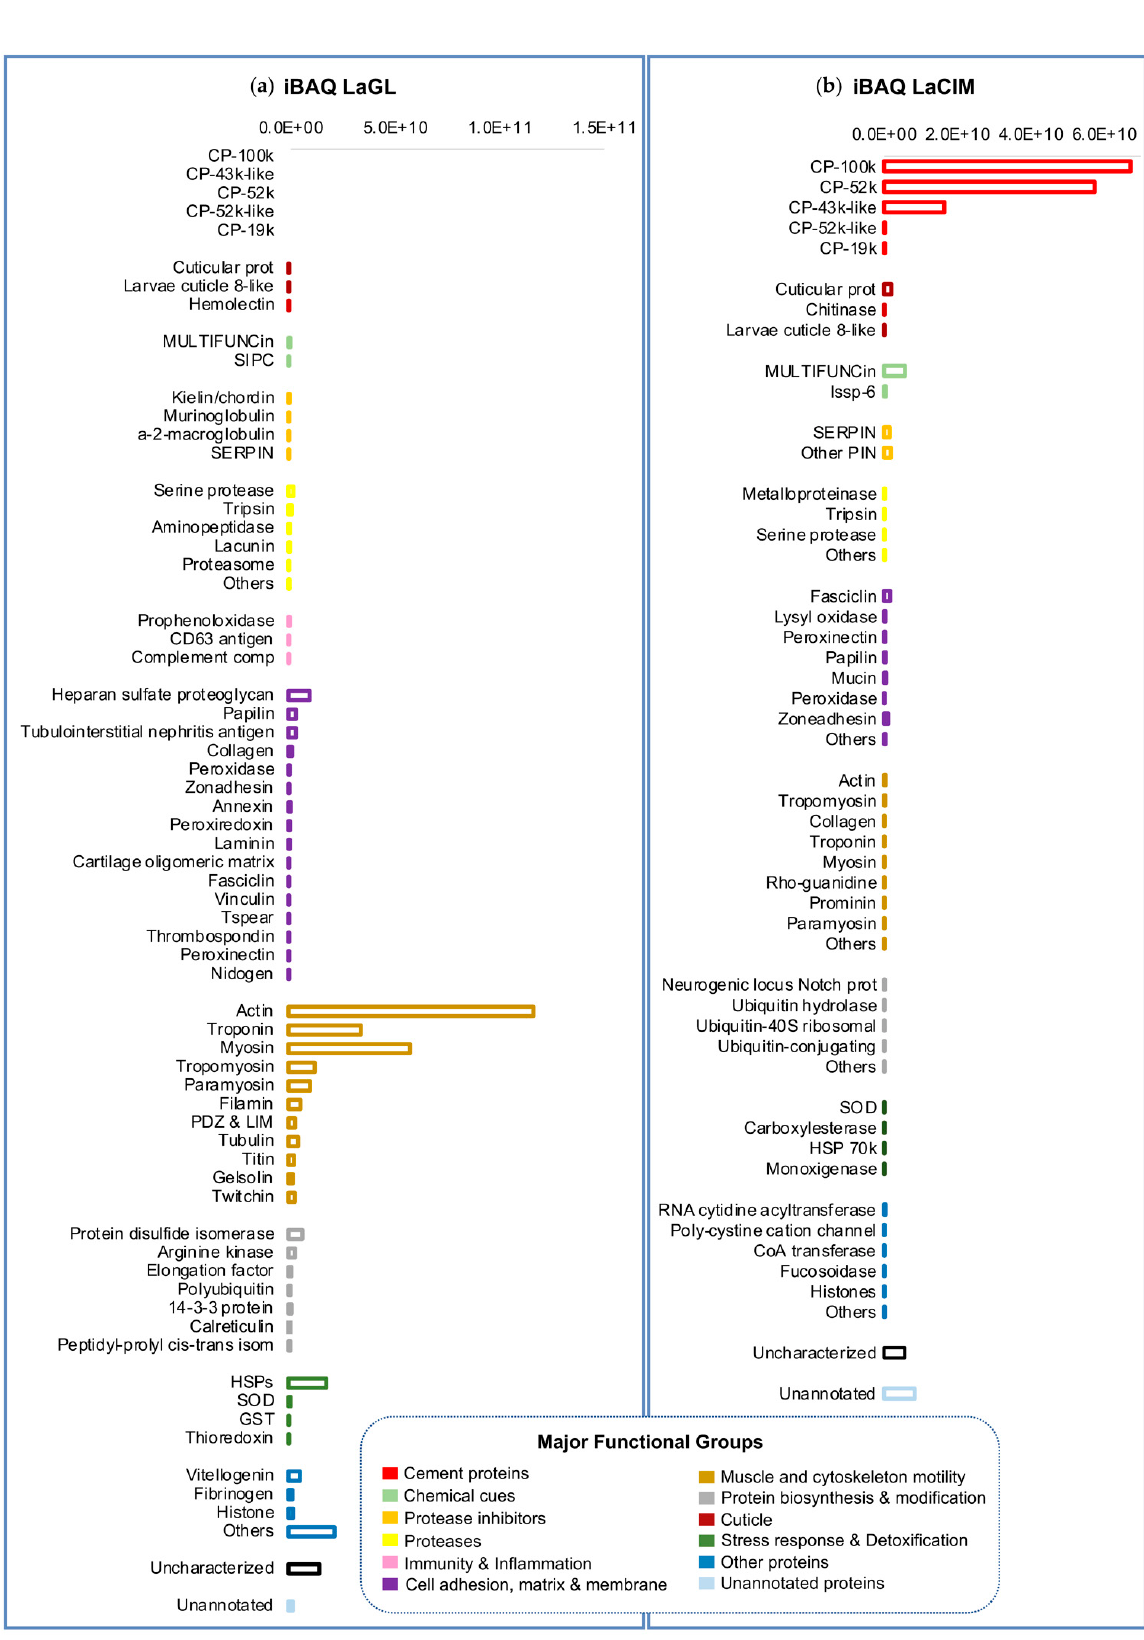
Figure 4. Relative protein abundance within ( a ) the gland proteome (LaGL); and ( b ) cement proteome (LaCIM) of the cosmopolitan goose barnacle Lepas anatifera . Absolute protein abundance of broad protein families, shown as a single bar, was obtained using an intensity Based Absolute Quantification (iBAQ) score calculated by MaxQuant. The horizontal scales of bars differ between samples (LaGL and LaCIM), being highest in the gland